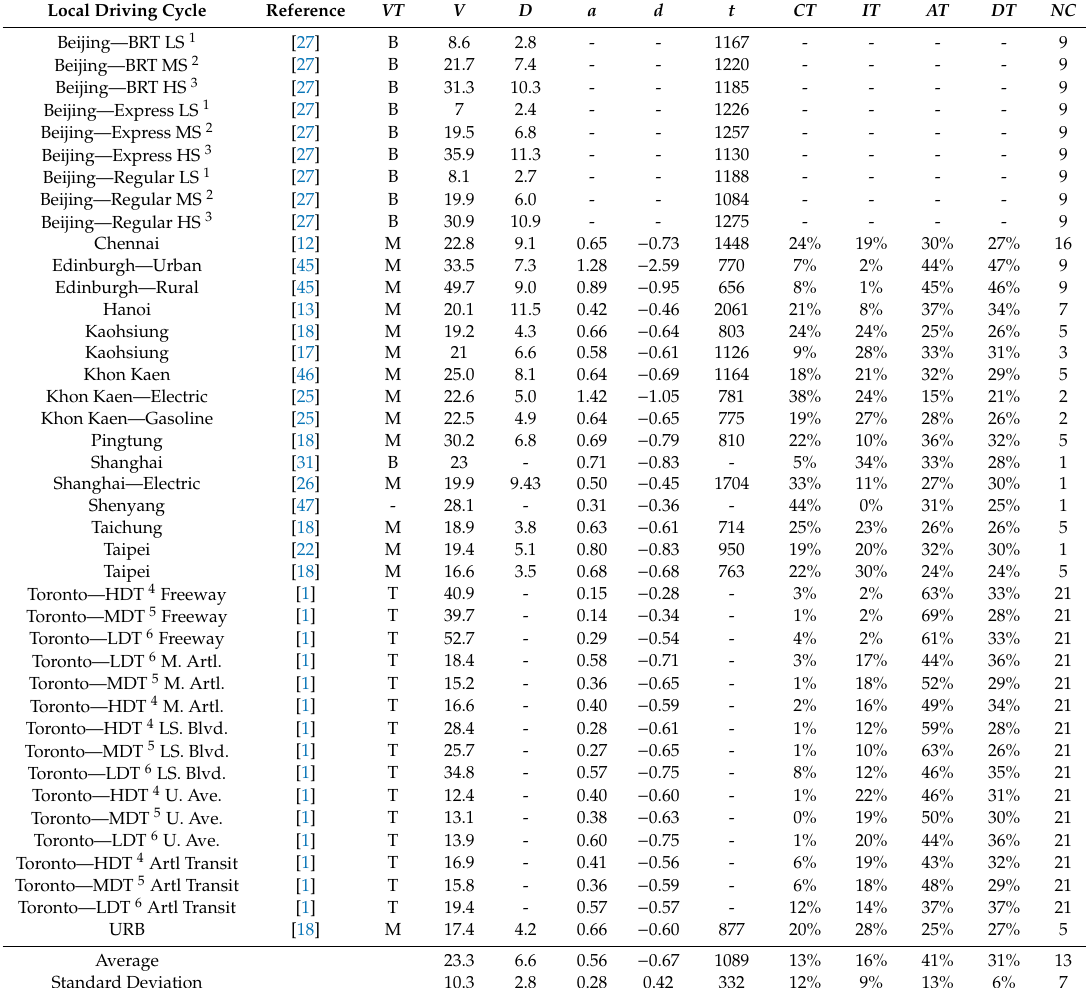
Table 5. CP ORIG for the LDCs for vehicles di ff erent from passenger cars: bus (B), motorcycle (M), truck